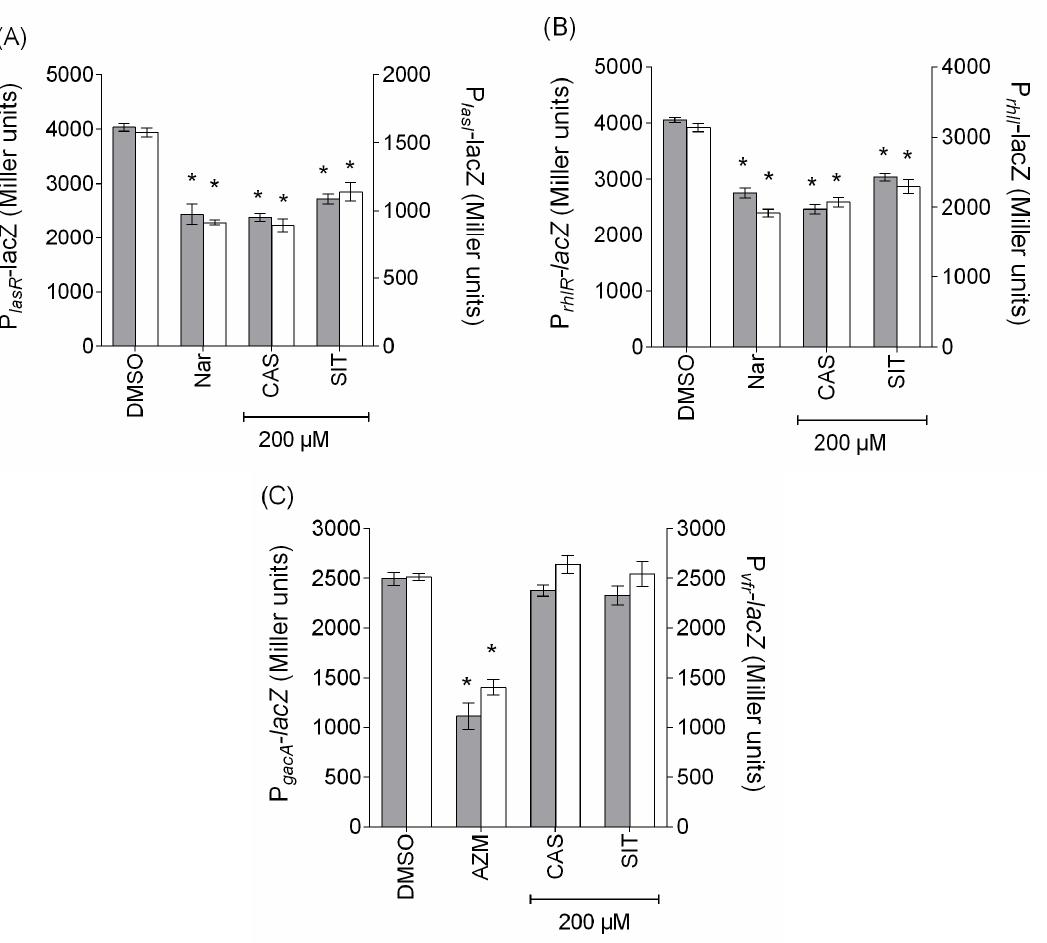
Figure 5. Effect of cassipourol and β -sitosterol on QS genes ( lasI/R and rhlI/R ) and global activator genes ( gacA and vfr ) expression in P. aeruginosa PAO1: ( A ) effect of cassipourol, β -sitosterol and α -amyrin on lasR (grey bar) and lasI (clear bar) expression following 18 h of growth; ( B ) effect of cassipourol, β -sitosterol and α -amyrin on rhlR (grey bar) and rhlI (clear bar) expression following 18 h of growth; and ( C ) effect of cassipourol, β -sitosterol and α -amyrin on gacA (grey bar) and vfr (clear bar) expression following 18 h of growth. Each isolated compound was tested at 200 µ M. Naringenin (Nar, 4 mM) or Azithromycin (AZM, 2 µ g/mL = 2 µ M) are used as a quorum sensing inhibitor control. Gene expression was measured as the β -galactosidase activity of the lacZ gene fusions and expressed in Miller units. Error bars represent the standard errors of the means; all experiments were performed in quintuplicate with three independent assays and asterisks indicate samples that are significantly different from the DMSO (One-way ANOVA followed by Dunnett’s test of multiple comparisons; p < 0.01).